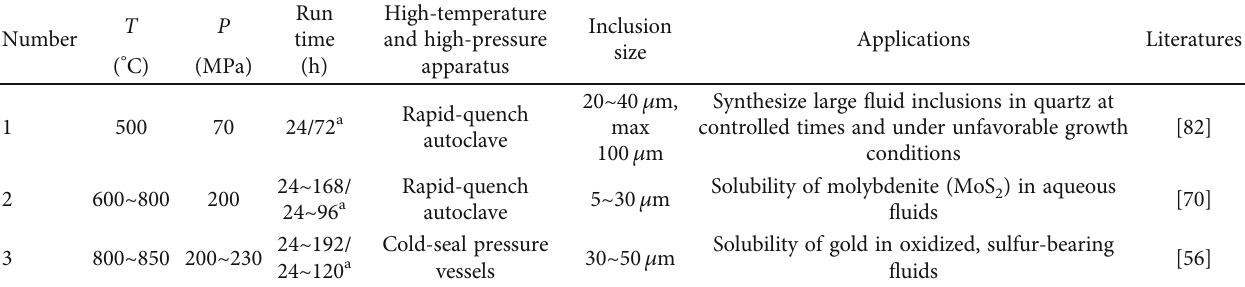
Table 5: Some typical applications of the in situ fracturing re fi lled FIS